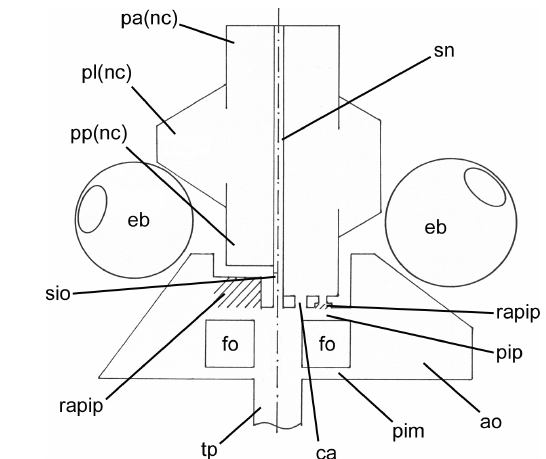
Figure 16. Schematic horizontal section of the fetal nasal capsule and basicranium of the orbitotemporal region of Tupaia (left) and Ptilocercus (right) to illustrate the arrangement of the septum in- terorbitale and adjacent structures that are influenced by orientation of the eye ball and orbit. Abbreviations: ao, ala orbitalis; ca, carti- lago antorbitalis; eb, eye ball; fo, foramen opticum; nc, nasal cap- sule; pa, pars anterior; pim, pila metoptica; pip, pila praeoptica; pl, pars lateralis; pp, pars posterior; rapip, radix anterior pilae praeop- ticae; sio, septum interorbitale; sn, septum nasi; tp, trabecular plate.